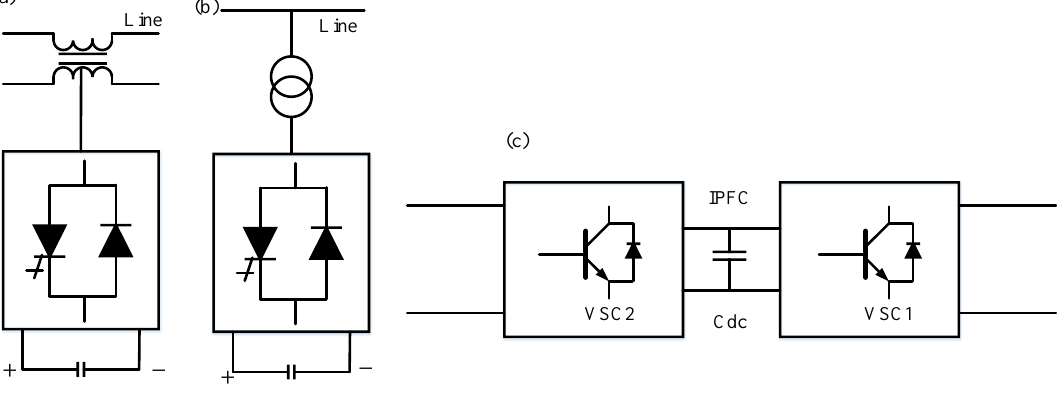
Figure 18. ( a ) SSSC, ( b ) STATCOM, ( c ) IPFC [44]. Coordination Control Damping